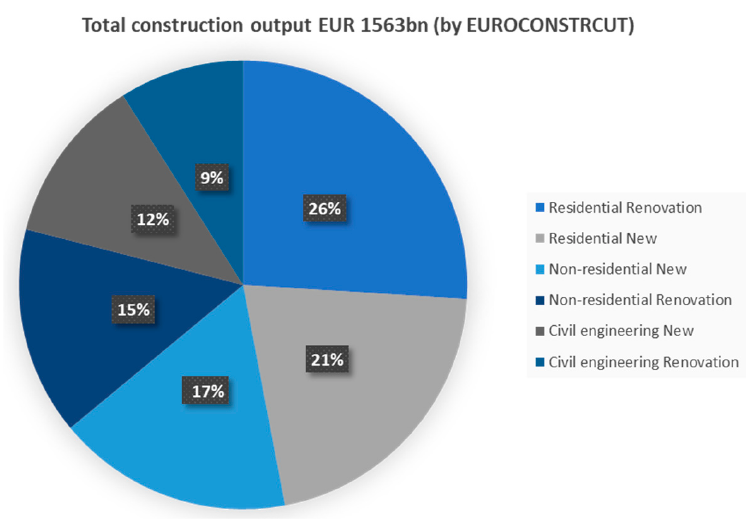
Figure 1. Construction market by sub-sectors according to EUROCONSTRUCT (November 2018).